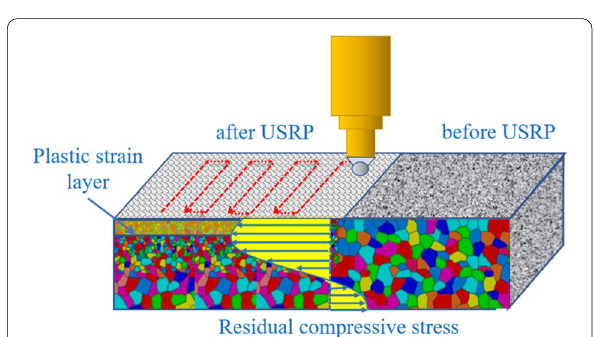
Figure 3 Schematics of USRP strengthening process